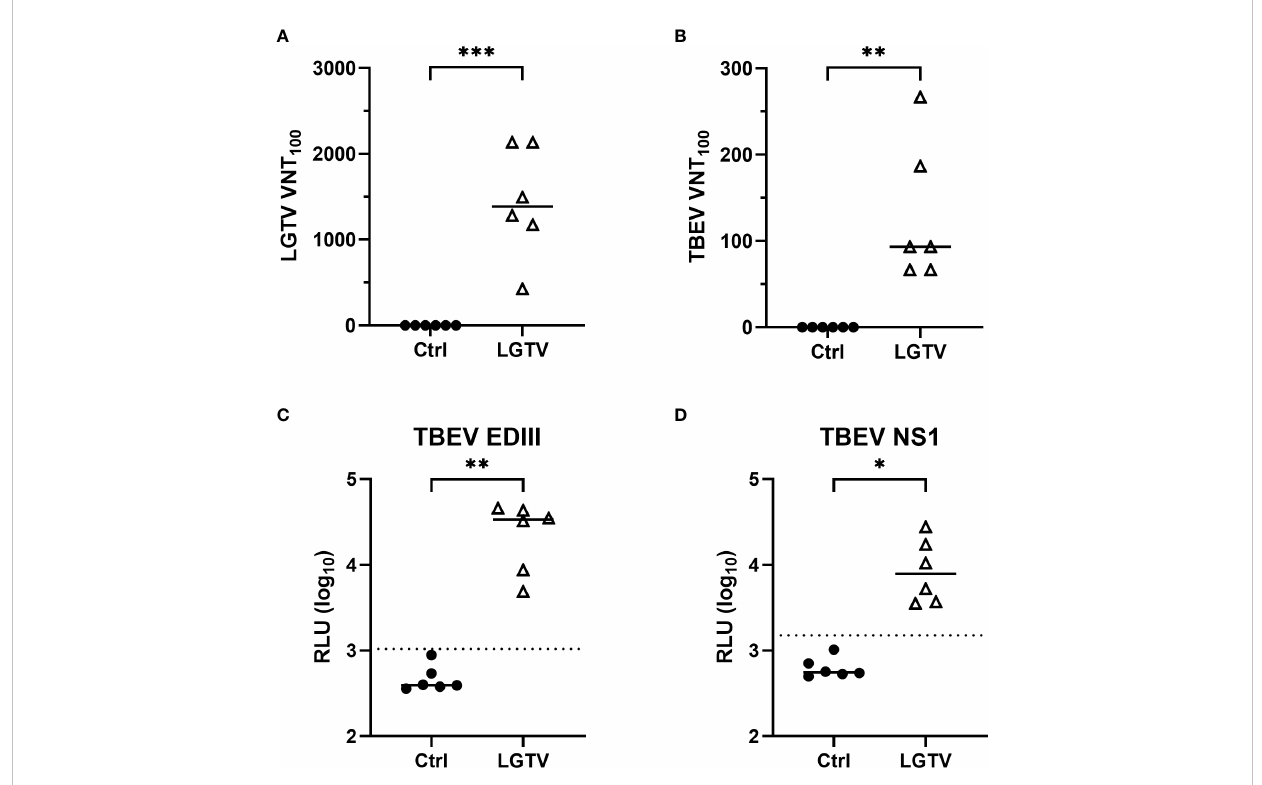
FIGURE 1 TBEV cross-reactive antibodies in the serum of LGTV immunized mice. Serum collected from control ( (cid:129) ) or LGTV ( D ) infected mice (n=6) were tested for their ability to block the infection of (A) LGTV (p = 0.0003) and (B) TBEV (p = 0.0029) in VeroE6 and A549 cells, respectively. The graphs show the titer at which 100% virus neutralization is achieved (VNT 100 ). LIPS assay with 1:100 dilution of serum detected antibodies against (C) domain III of the TBEV E protein (p = 0.0029) and (D) TBEV NS1 protein (p = 0.0214). Luciferase activity was measured in three independent experiments and is displayed as mean values of log 10 RLU. Luminescence values higher than the average of negative samples plus fi ve-times the standard deviation (dotted line) are considered positive. Median is shown in all graphs. *p<0.05, **p<0.01 and